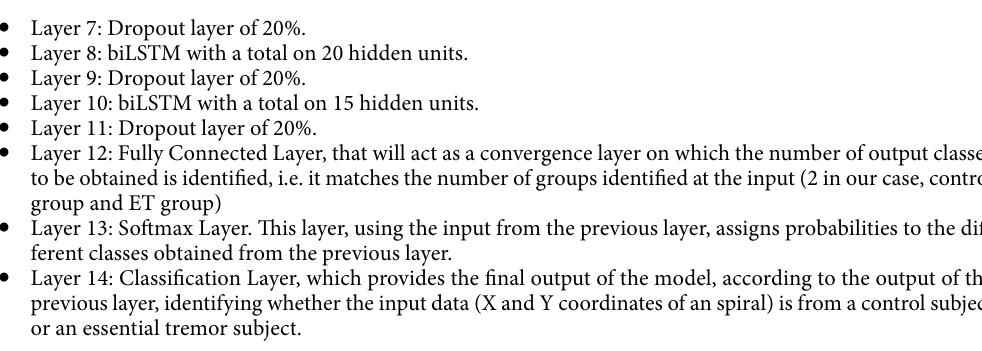
Figure 5. Structure of the LSTM used as a